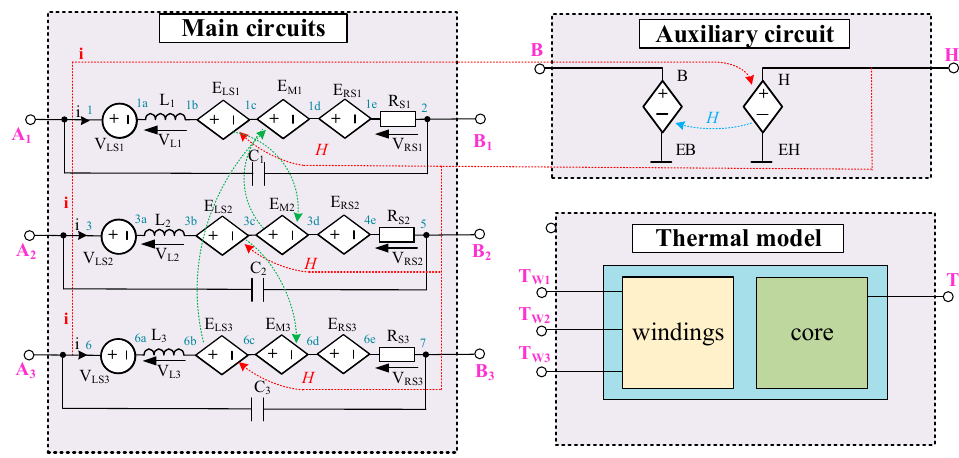
Figure 1. Network representation of an electrothermal model of a coupled inductor. The developed model consists of three blocks: the main circuit, the auxiliary circuit, and the thermal model. The structure of the proposed model is shown in Figure 2. This model takes into account the influence of frequency, skin effect, direct current, temperature, and thermal phenomena on the characteristics of the coupled inductors.